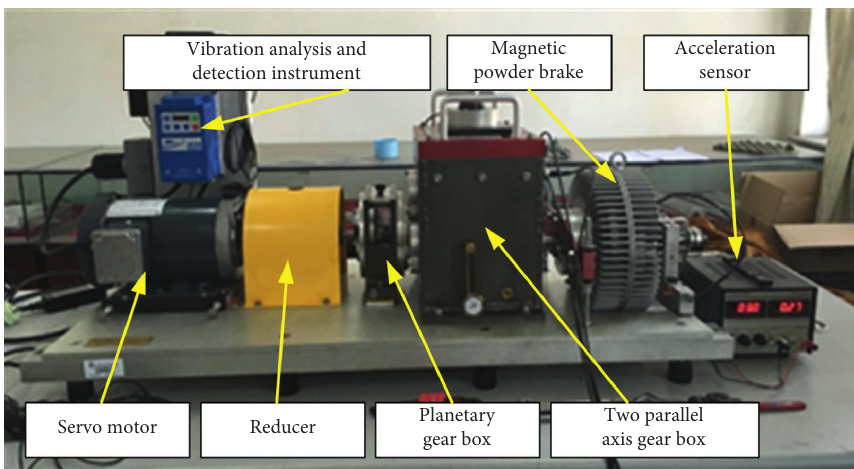
Figure 6: Fault diagnosis testbed of rotating machinery.